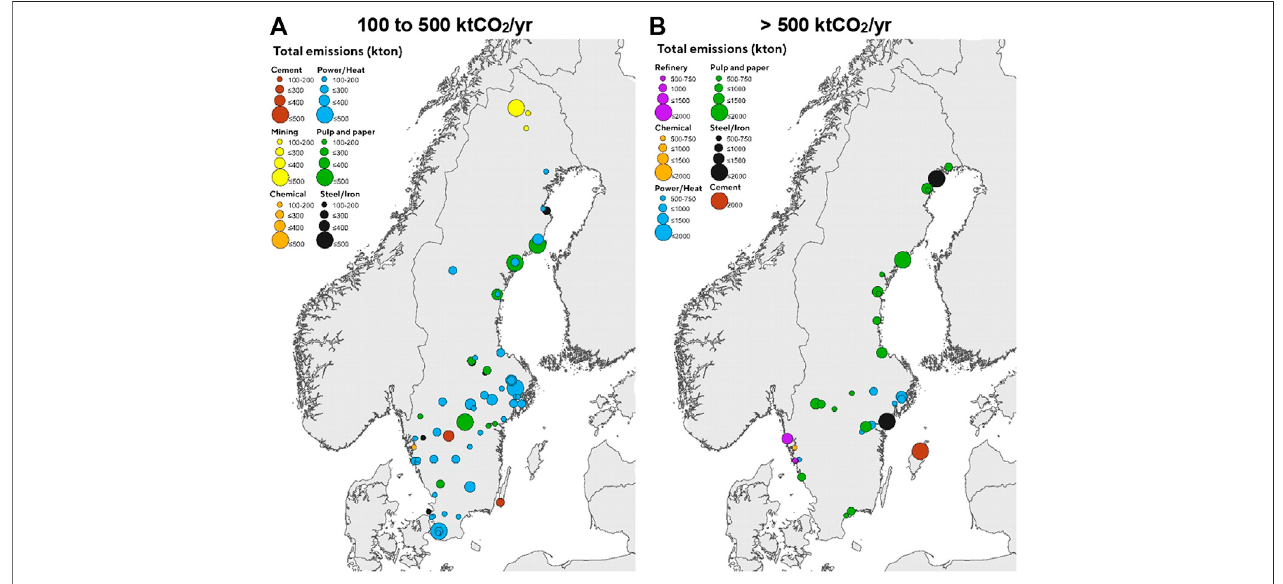
FIGURE2| Swedishemissionssourcesfromdifferenttypesofplantswith: (A) emissionsintherangeof100 – 500 ktCO 2 /year;and (B) emissions > 500 ktCO 2 /year. Reproduced from (Johnsson and Kjärstad, 2019).